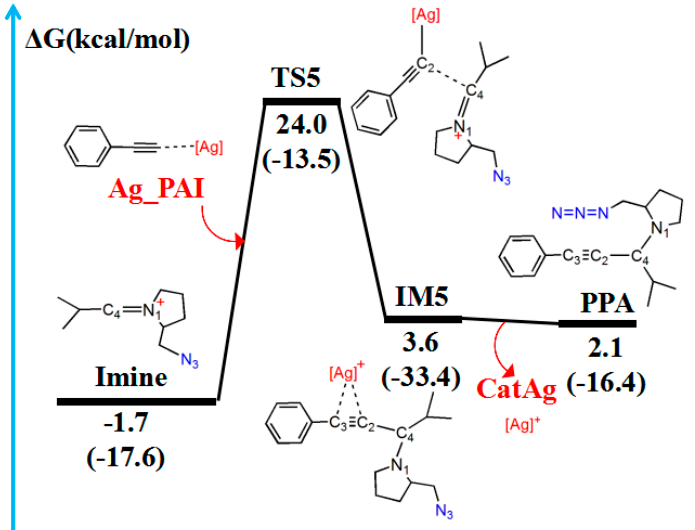
Figure 7. Reaction pathway of Imine and Ag_PAI. The relative free energy of the reaction pathway involving hydrogen is provided in kcal/mol. The relative enthalpy is also provided in brackets for reference (in kcal/mol).